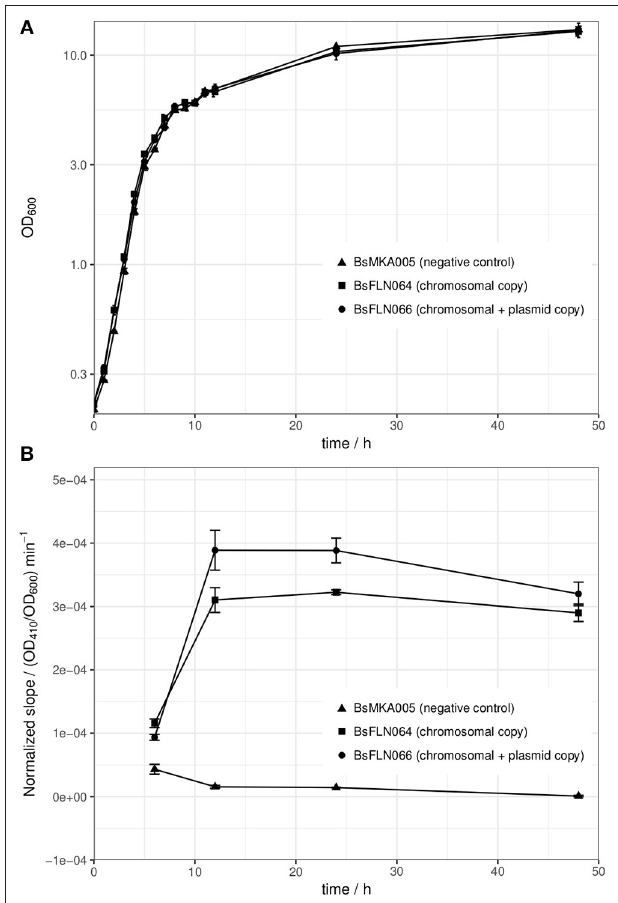
FIGURE 3 | (A) Averaged growth curves of strains BsMKA005 (negative control), BsFLN064 (chromosomal copy), and BsFLN066 (chromosomal + plasmid copy); (B) OD 600 -normalized slope values of phospholipase C assay as a measure of enzymatic activity. Since amount of substrate and volume of enzyme solution ( = diluted crude supernatant) were constant and differences in OD 600 at sampling time are normalized, the slope is a direct indicator for the amount of active enzyme produced by the according strain. The data used for calculation of the slope consists of 4h of kinetic measurement. Plotted values are averages of n = 3 biological replicates with error bars showing standard